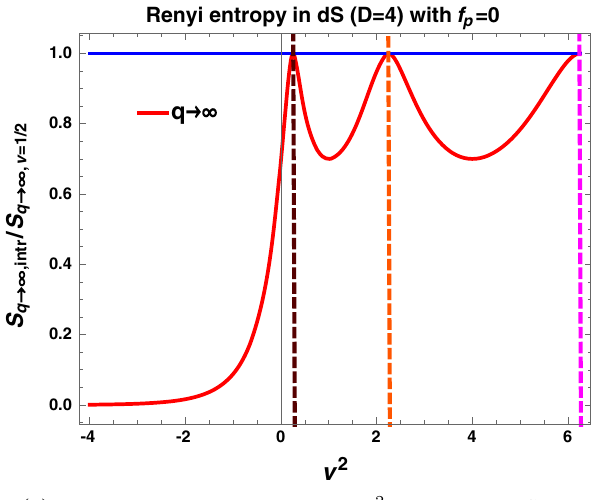
the different values of the parameter q as given by q = 0 . 1 ( black ), q = 0 . 3 ( purple ), q = 0 . 5 ( green ), q = 0 . 7 ( blue